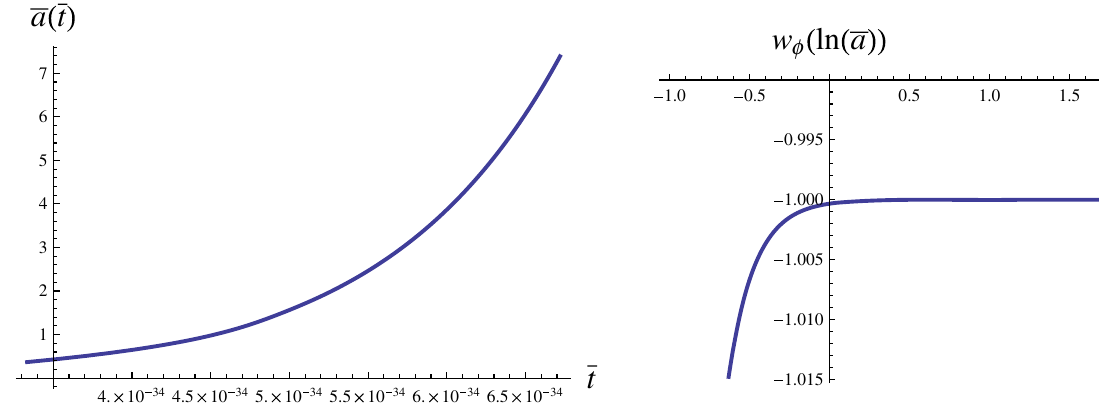
Fig. 7 Illustration of the typical evolution of ¯ H with respect to ln ( ¯ a ) at the beginning of the inflation epoch. We assume that γ = 1 . 16 × 10 − 69 s 2 and ¯ a 0 = 1 at the beginning of the inflation epoch. ¯ H is expressed in units of km . Note that, for the late time, ¯ H can be treated s Mpc as a constant